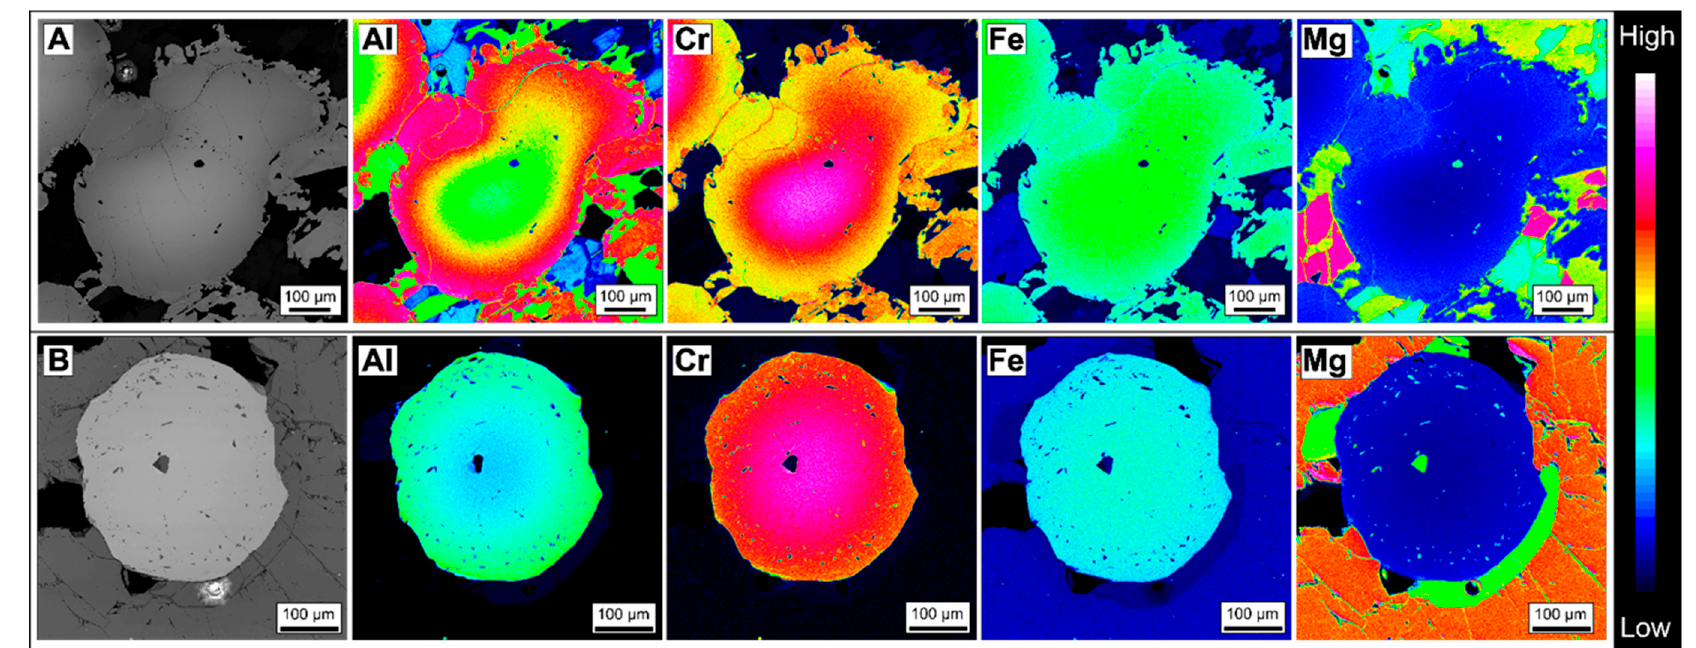
Figure 9. Backscattered electron images and false-color compositional maps of zoned chromites from the Ulamertoq peridotite body. ( A ) Chromite surrounded by chlorite, amphibole, and orthopyroxene showing a well-defined zonation of a Cr-rich core and Al-rich rims. Some chlorites fill the pores in the outer rim portions. The outermost rim occurs as irregular overgrowth, and is slightly Cr-rich; ( B ) Accessory chromite in the peridotite envelope enclosed by olivine and minor orthopyroxene shows less variation from core to rim.